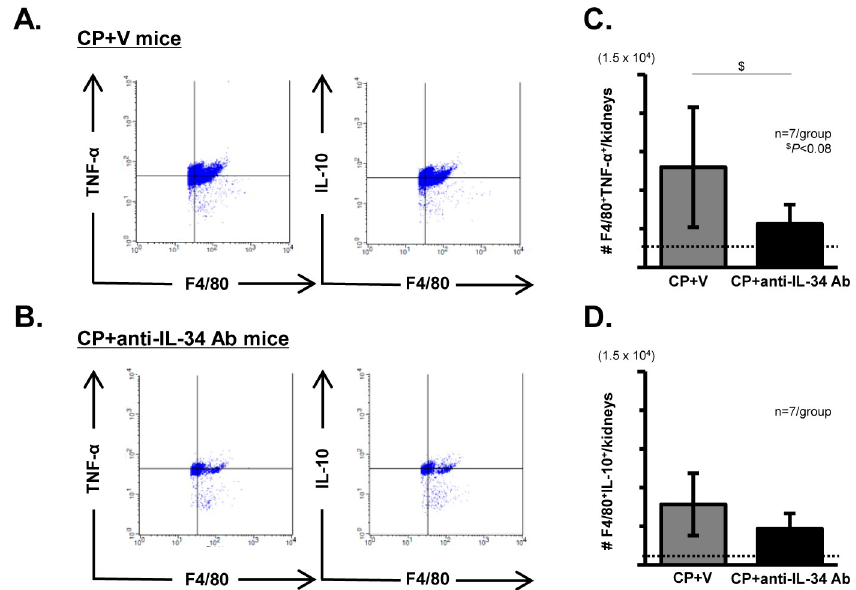
Fig 7. Intra-renal cyto-destructive (M1-like) and cyto-protective (M2-like) M ø accumulation in CP-N mice. Single-cell suspensions from both kidneys of each mouse were stained. The CD11b + F4/80 + cell population was gated first, then the F4/80 + TNF α + or IL-10 + cell population was gated. Representative FACS plots with gating for F4/ 80 + TNF α + or IL-10 + cells in the CP+V ( A ) and CP+anti-IL-34 Ab mouse ( B ) groups. Graphs of the numbers of cyto- destructive M ø s (F4/80 + TNF α + ) ( C ) and cyto-protective M ø s (F4/80 + IL-10 + ) ( D ) in the kidneys of the mouse groups. Data are expressed as the mean ± SEM. Broken lines indicate the data for NC mice (n = 3). The Mann-Whitney U test was used for statistical